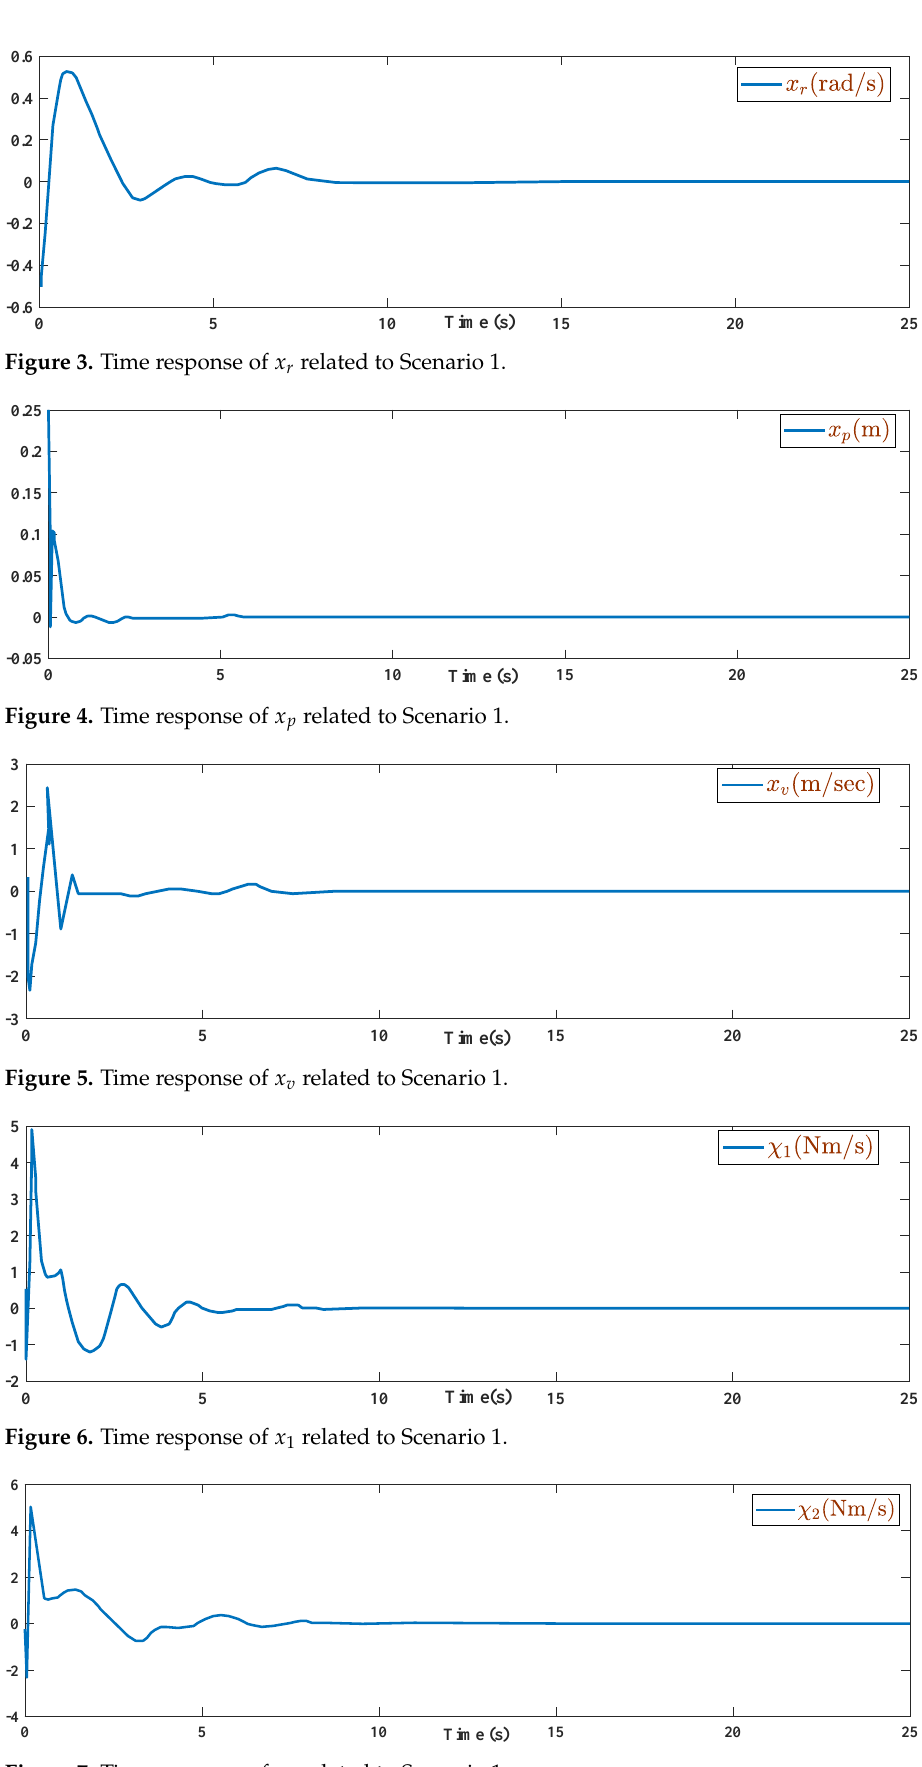
Figure 7. Time response of x 2 related to Scenario